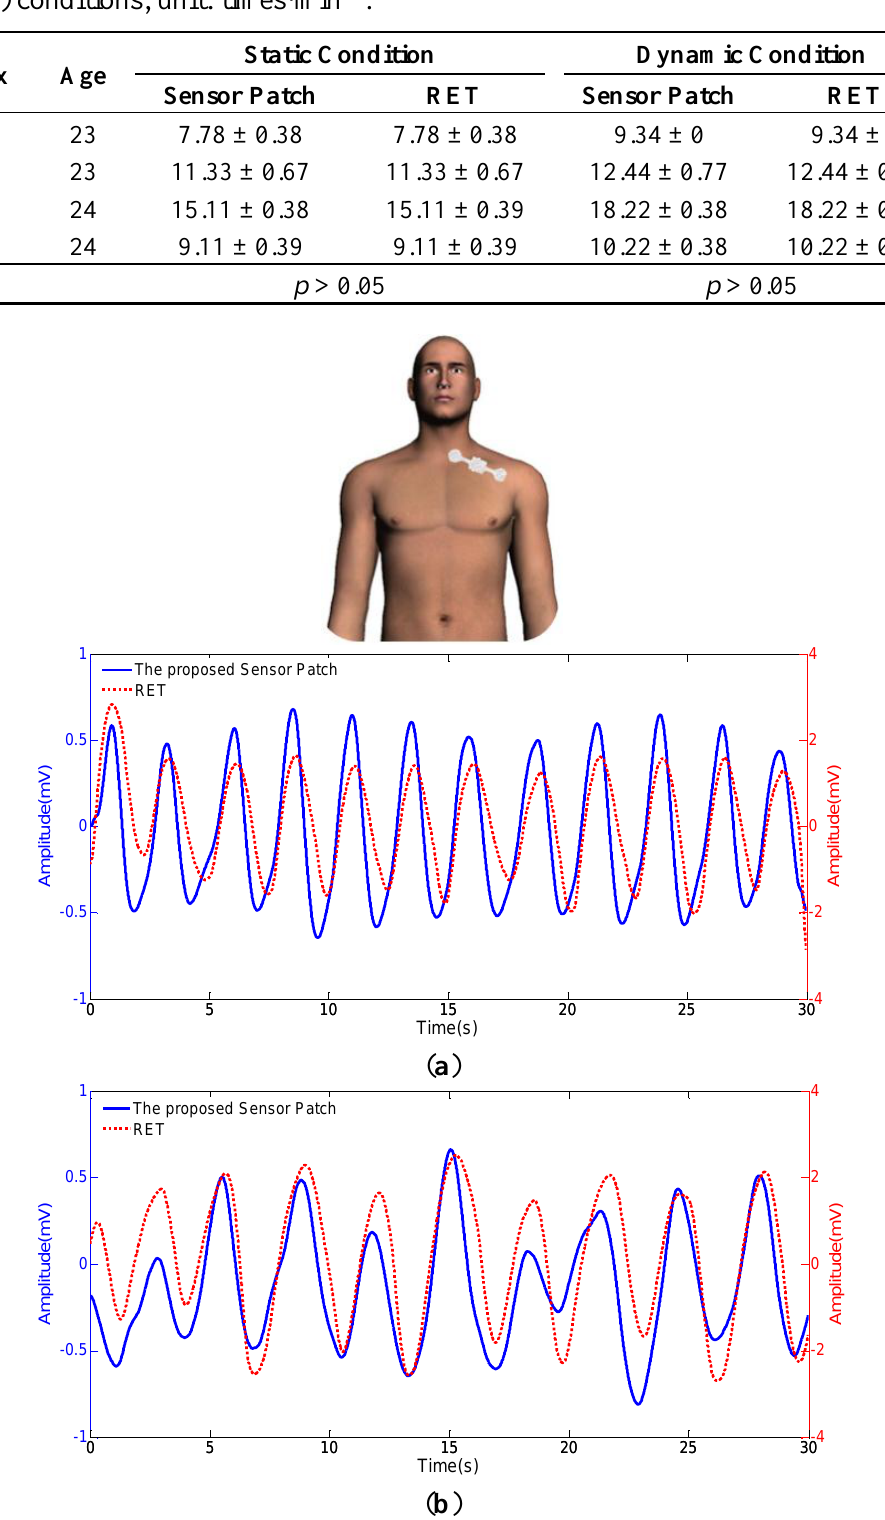
Figure 4. Comparison of the electrical signals acquired from the proposed sensor patch, and a commercial respiratory effort transducer (RET) under ( a ) static (sitting), and ( b ) dynamic (walking)